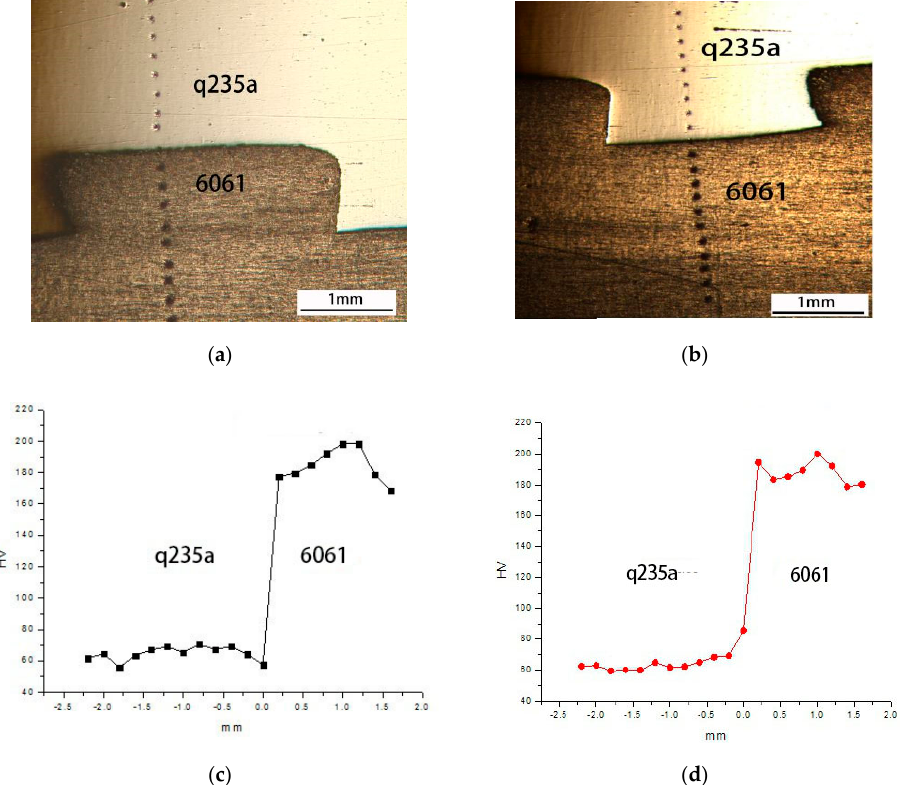
Figure 7. The microhardness characteristics and corresponding results of two different areas at the joining interface: ( a ) Test position of microhardness (the upper of dovetail groove); ( b ) Test position of microhardness (the bottom of dovetail groove); ( c ) test results of microhardness (the upper of dovetail groove); ( d ) test results of microhardness (the bottom of dovetail groove).